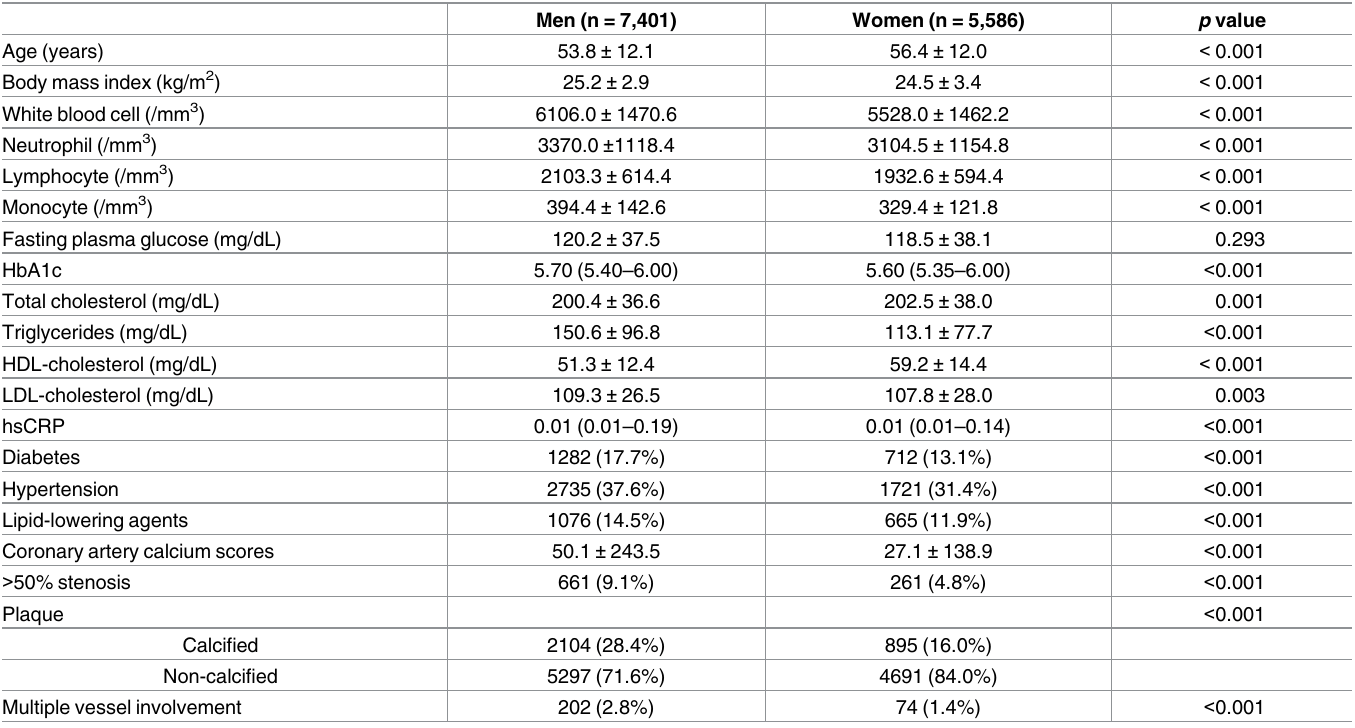
Table 1. Descriptivecharacteristics of study population.